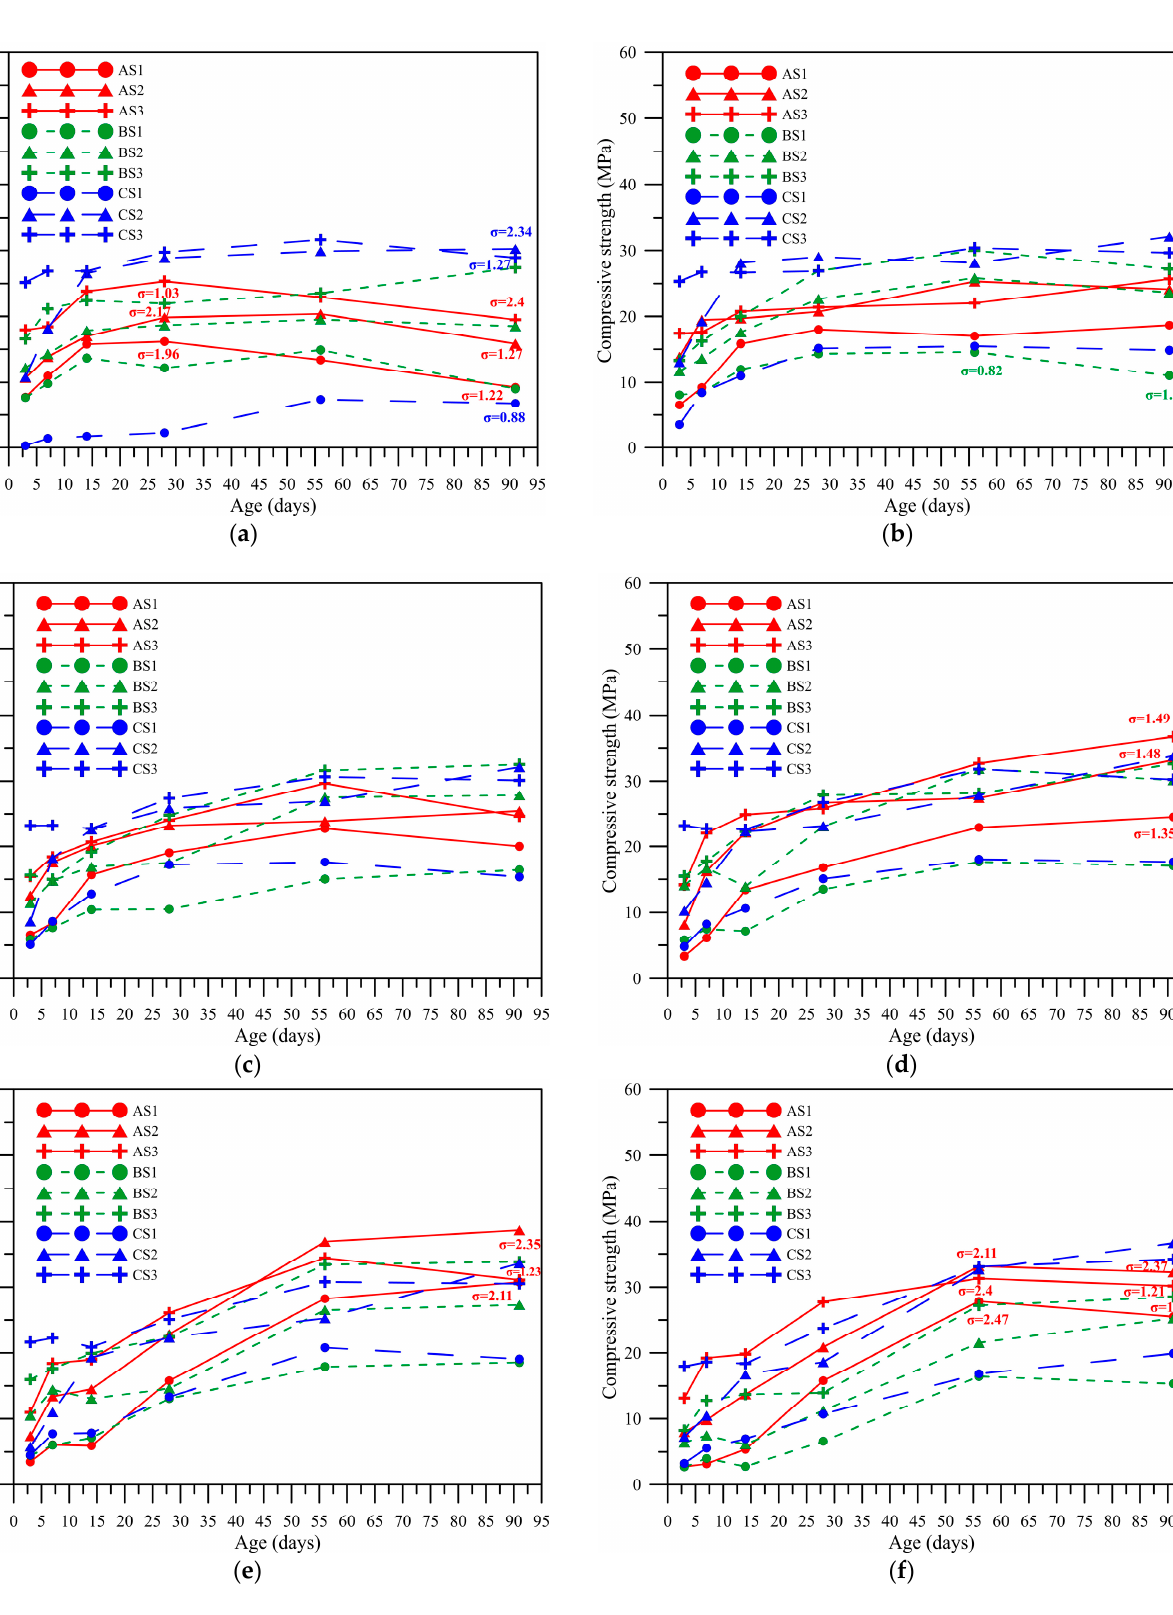
achieved. When AE% = 7% and the slag substitution amounts were 10%, 20%, and 30%, the strengths at 91 days were 30.75, 38.59, and 33.02 MPa, standard deviations of 2.11, 1.23 and 2.35, respectively, and increased gradually with age. When AE% = 8%, the strength began to decrease on Day 56. The compressive strengths were 27.84, 33.09, and 31.27 MPa with standard deviations of 2.47, 2.11, and 2.4 at the slag replacement rates of 10%, 20%, and 30% on Day 56, and 25.48, 32.19, and 30.17 MPa with standard deviations of 1.83, 2.37, and 1.21 on Day 91 . The specimens of the mix proportions of fly ash B and fly ash C still had a good increase amplitude in the case of AE 8% from Day 56 to Day 91, and the strength could be increased by increasing the alkali equivalent concentration.